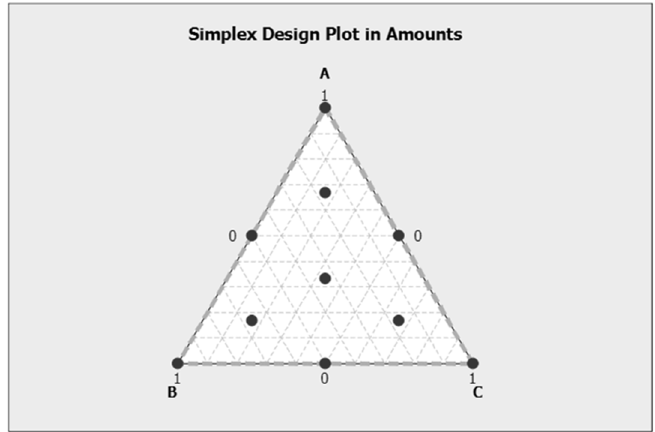
Figure 4. Simplex design plot in amounts.